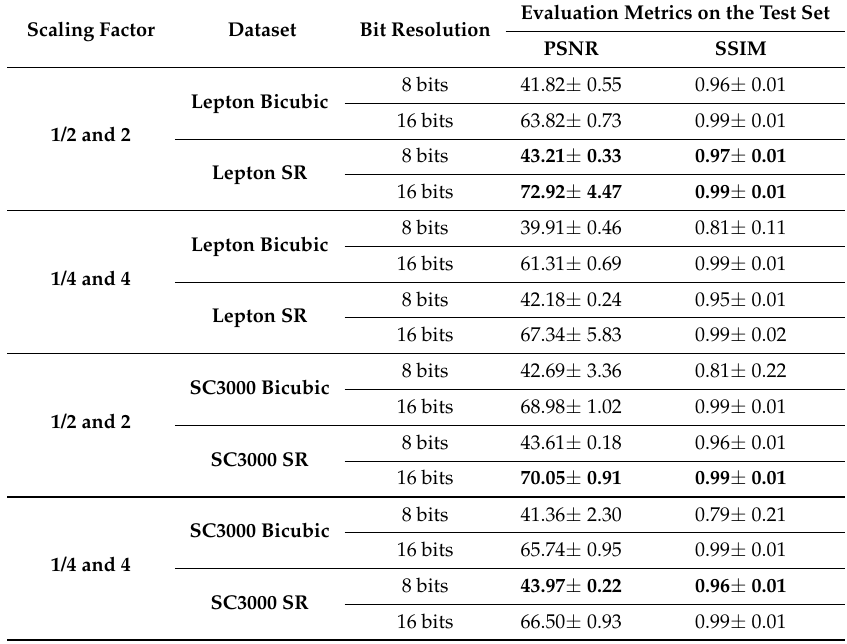
Table 1. Peak Signal to Noise Ratio (PSNR) and Structural Similarity Index Metric (SSIM) for sequences downscaled with bicubic interpolation and then enhanced with the proposed SR DL model using scale of 2 and 4. Best result for each dataset was marked in bold (separately for 8 and 16-bit